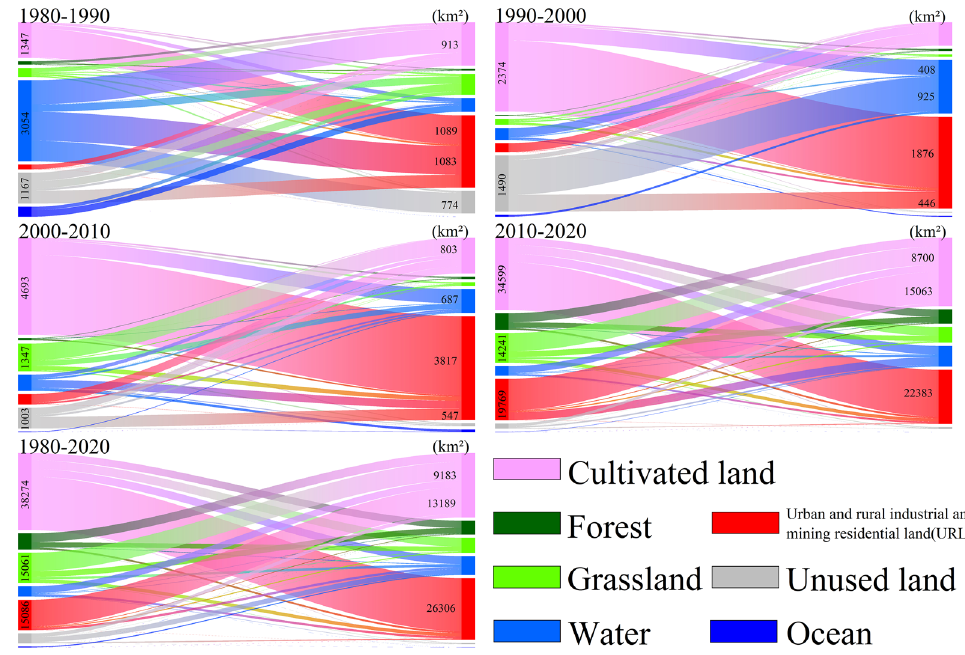
Figure 3. Sankey diagram of land use transfer in different